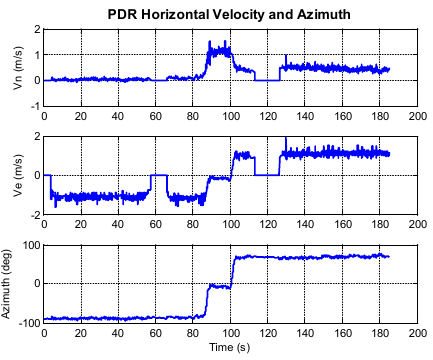
Figure 7. Results of PDR horizontal velocity and azimuth.